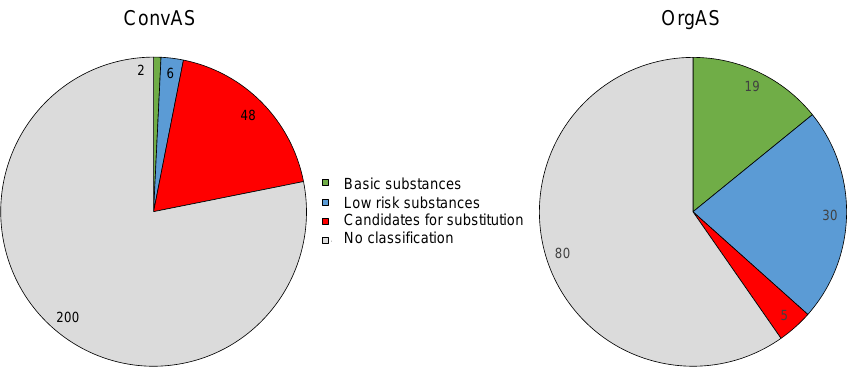
Figure 3. Comparison of basic risk classifications of active substances (AS) approved for use in conventional (ConvAS; n = 256) and organic agriculture (OrgAS, n = 134).